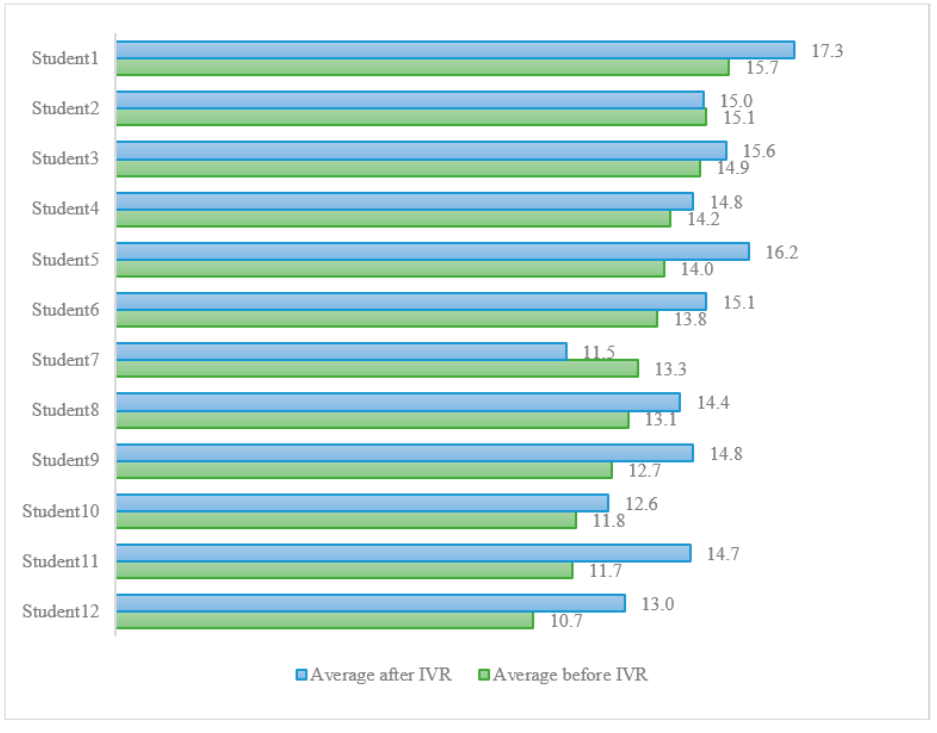
Figure 13. Individual qualifications before and after using IVR.